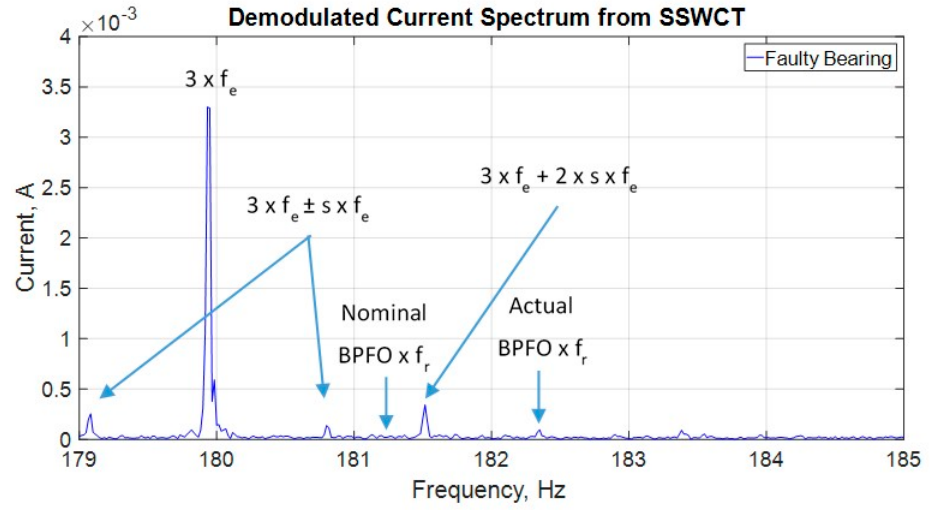
Figure 15. Demodulated current signal spectrum with zoom around the actual BPFO x f r frequency.